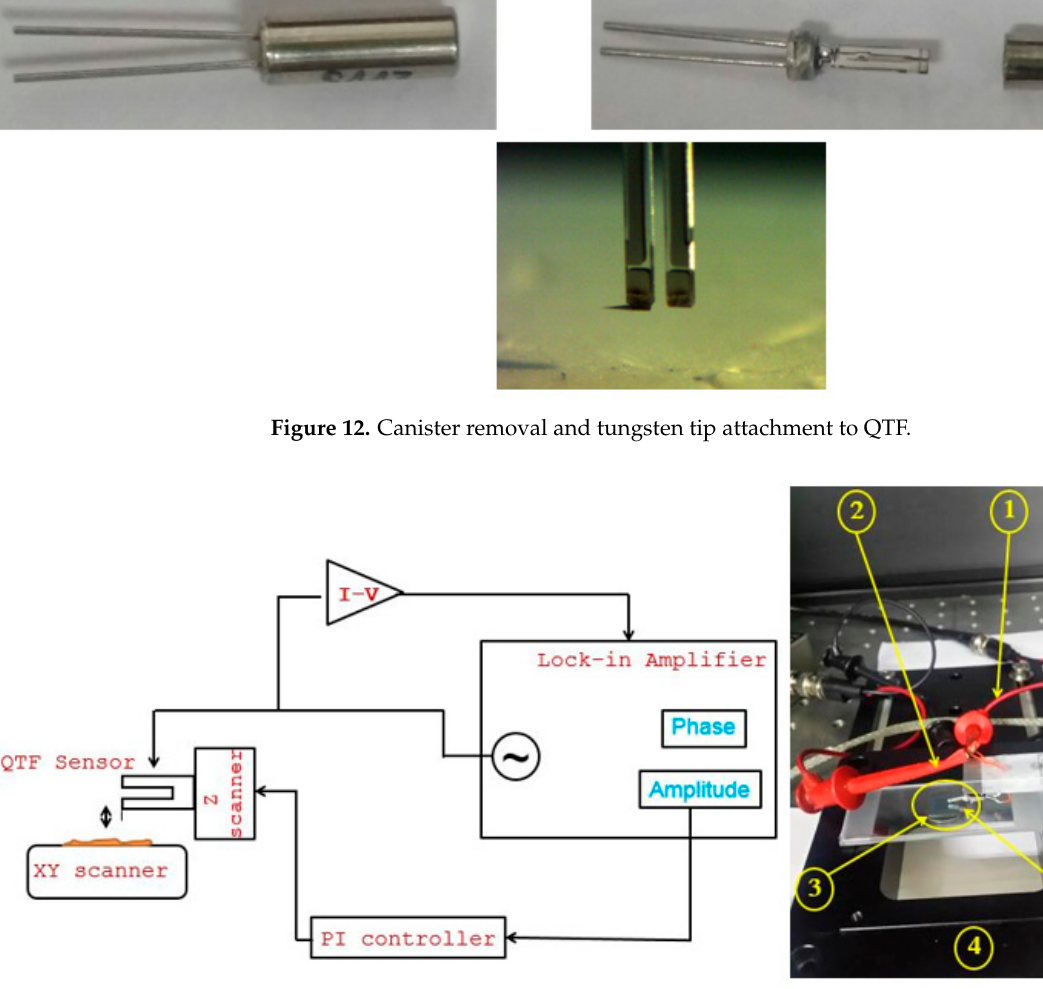
Figure 13. Schematic and Proof-of-concept experimental setup of Amplitude modulation imaging mode.